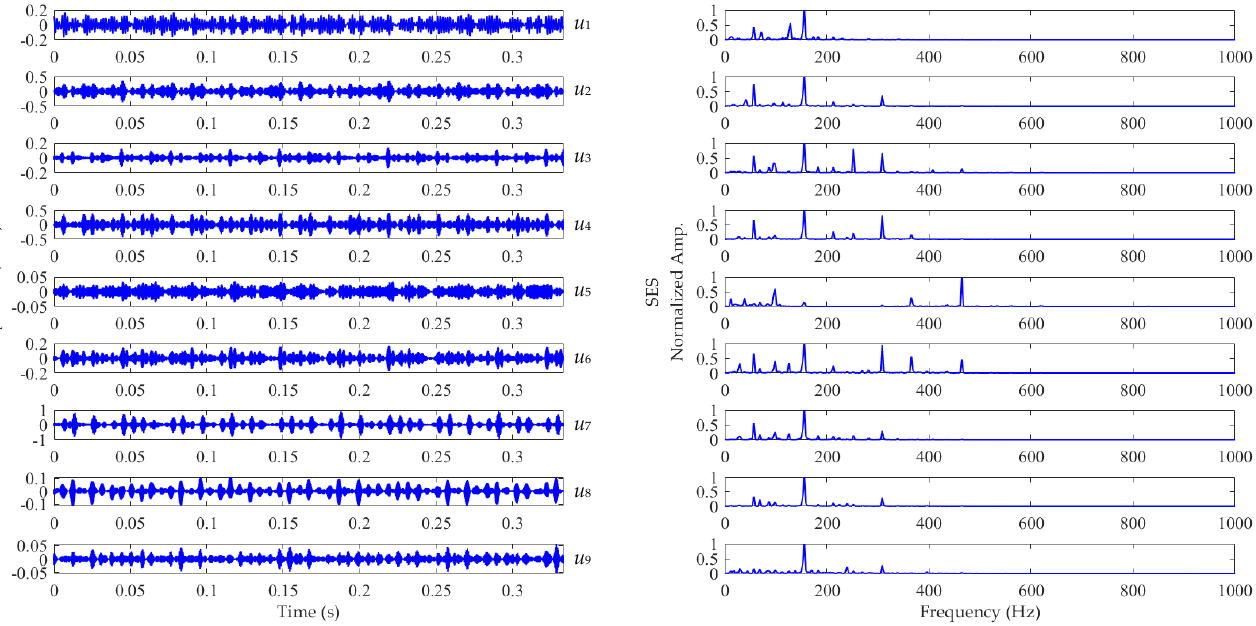
Figure 15. The optimal target mode: ( a ) time − domain waveform and ( b ) SES.